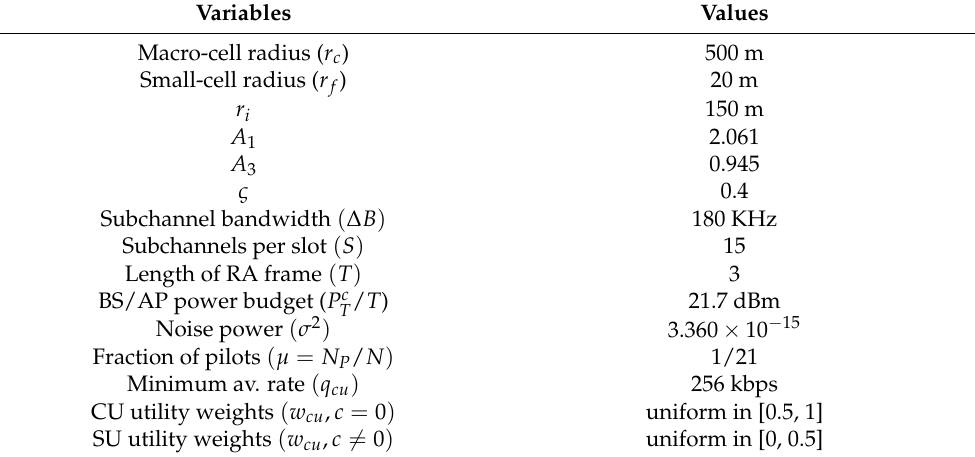
Table 2. Simulation